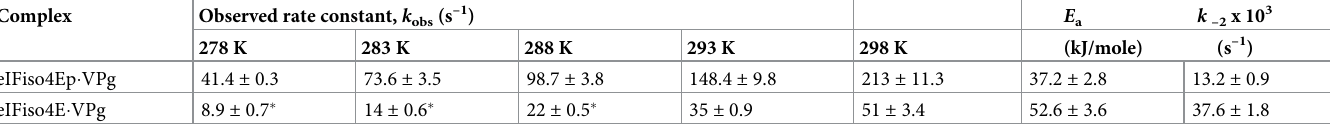
Table 1. Kinetic parameters for the binding of phosphorylated and unphosphorylated eIFiso4E with VPg of turnip mosaic virus.